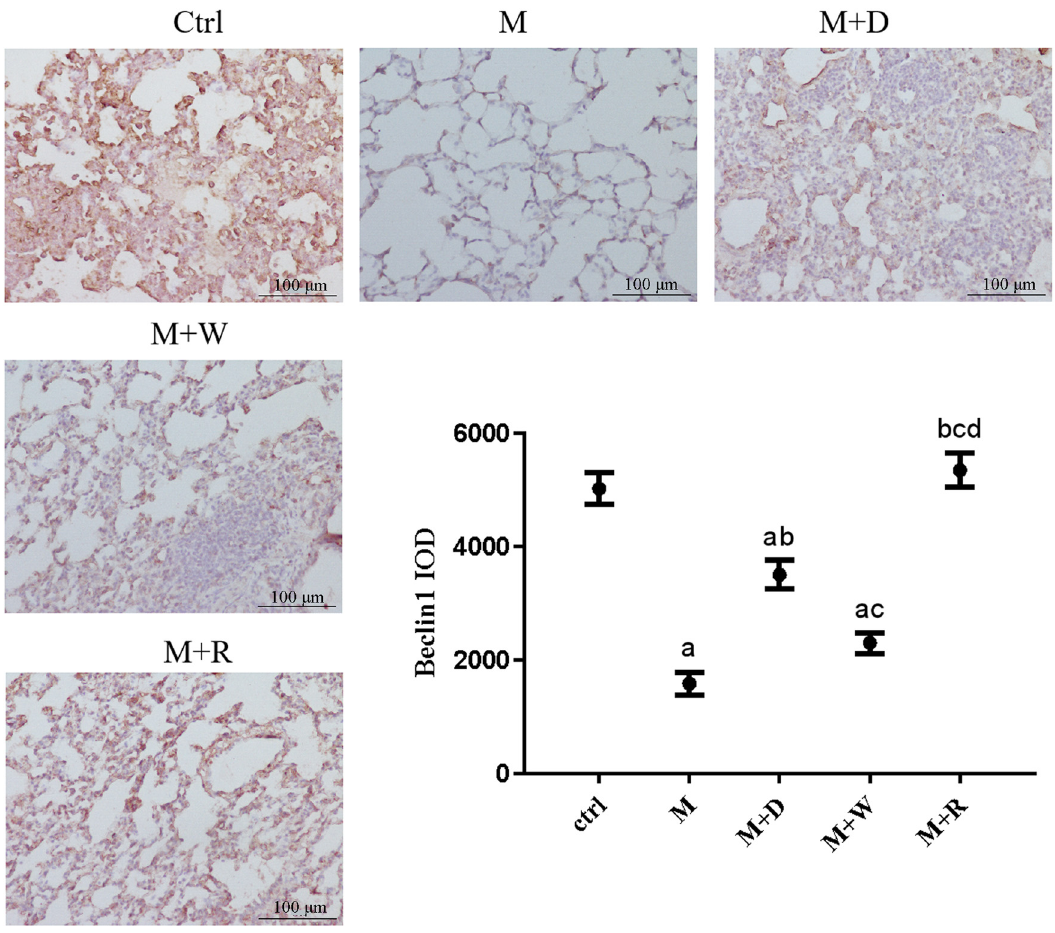
Figure 5: IHC image and expression levels of the mitochondrial autophagy marker Beclin1 in rat lung tissues of each group (× 200 ) : ( a ) statistically signi fi cant di ff erence from the Ctrl group ( P < 0.05 ) , ( b ) statistically signi fi cant di ff erence from the M group ( P < 0.05 ) , ( c ) statistically signi fi cant di ff erence from the M + D group ( P < 0.05 ) , and ( d ) statistically signi fi cant di ff erence from the M + W group ( P < 0.05 )